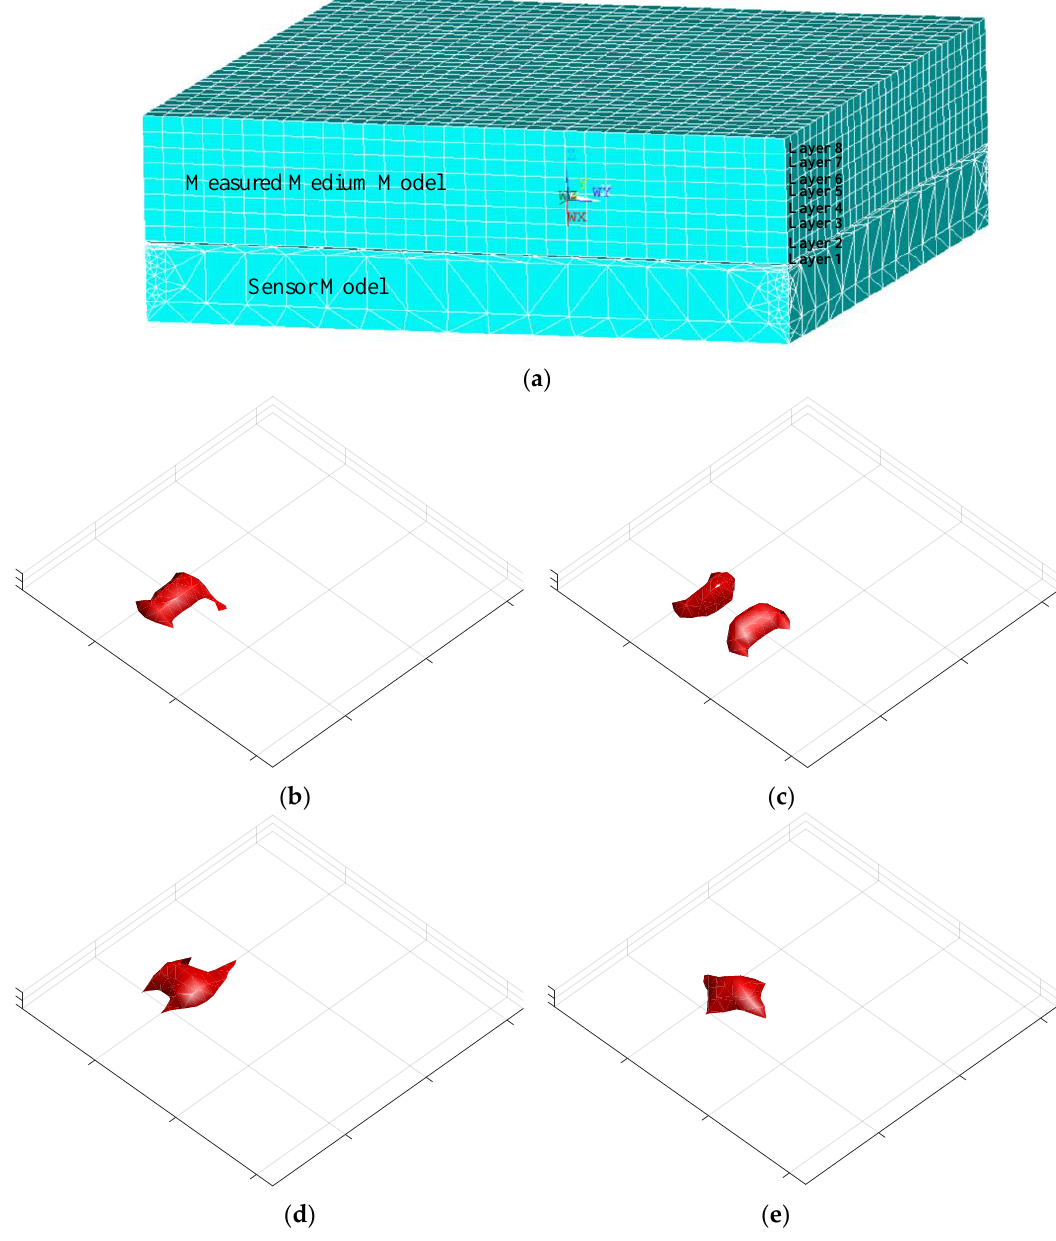
Figure 7. ( a ) FEM mesh model, and the computed sensitivity map between ( b ) electrodes 1 and 2, ( c ) electrodes 1 and 3, ( d ) electrodes 1 and 5, and ( e ) electrodes 1 and 6.